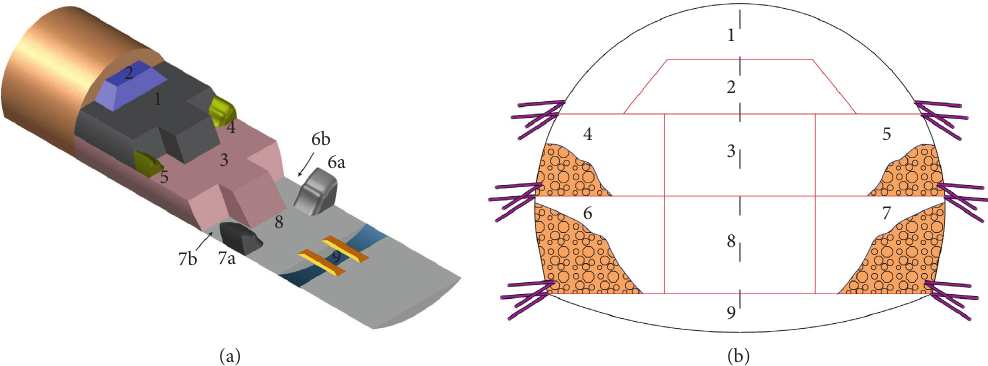
Figure 9: Complementary cyclic three-step excavation method. (a) Three-dimensional sketch of excavation. (b) Excavation of elevation view.